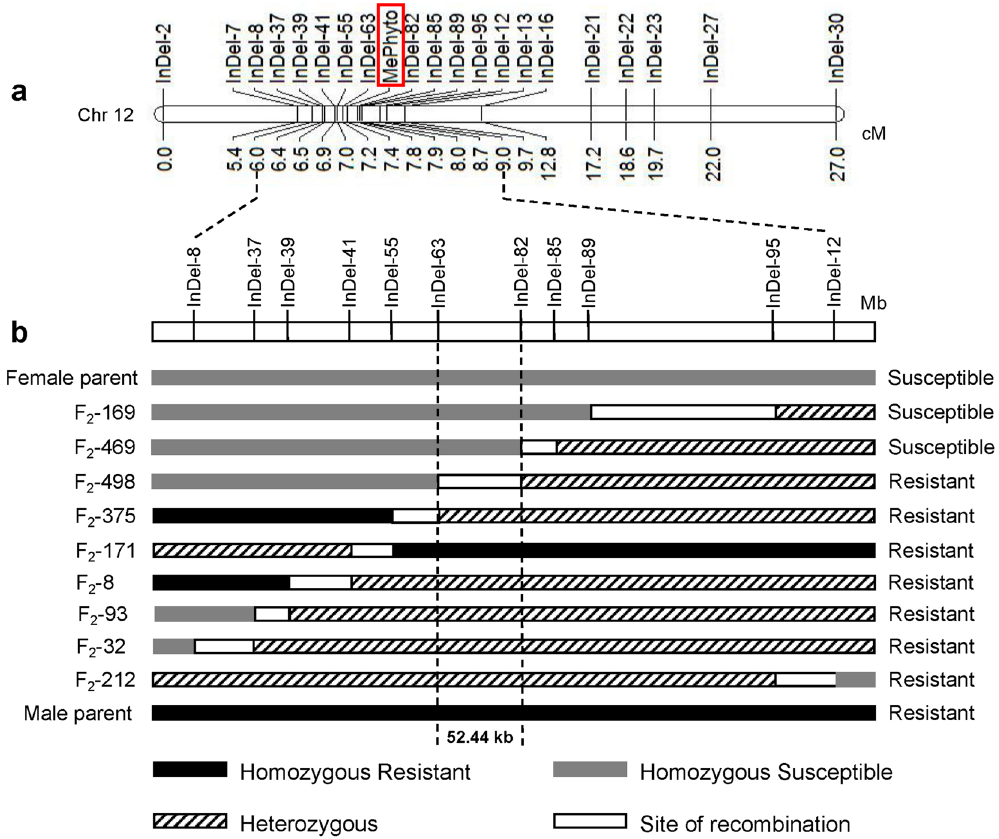
Figure 3. The linkage and partial physical maps of melon resistance gene MePhyto on chromosome 12. ( a ) Genetic linkage map constructed according to F 2 population with 20 markers. ( b ) Partial physical map of the genomic region between InDel-8 and InDel-12 and the graphical genotype of the recombinants in F 2 . MePhyto was narrowed to a 52.44 Kb region between InDel-63 and InDel-82 by analyzing the genotypes and phenotypes of nine